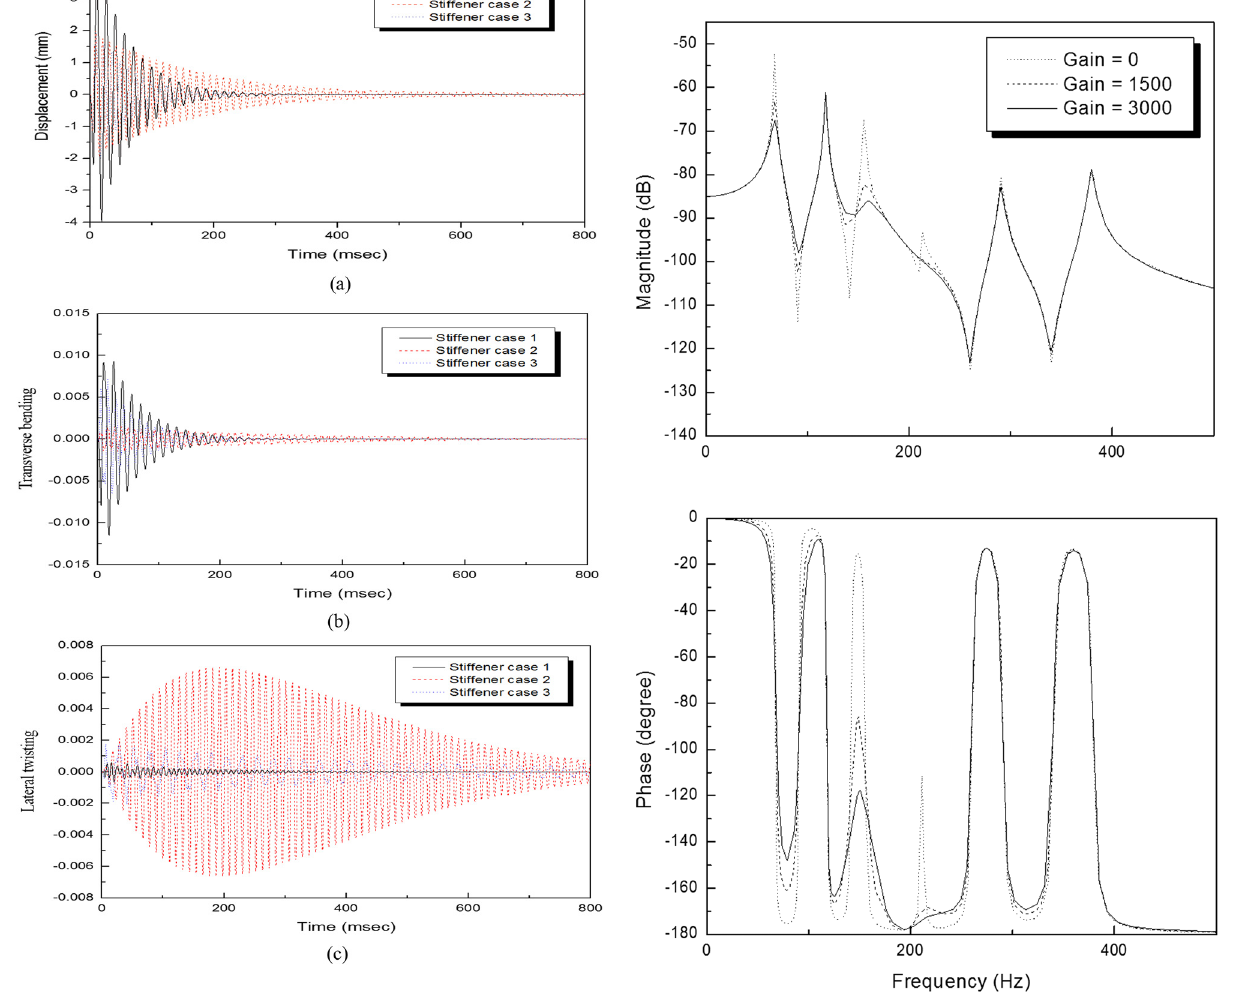
Figure 9: Frequency response of the shear - web case 1 due to a di ff erent feedback control